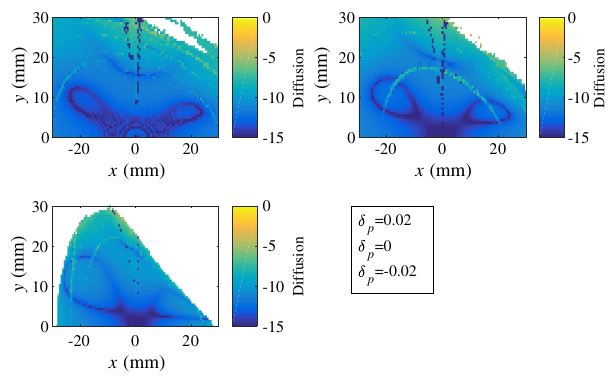
FIG. 8. Diffusion rate of particles distributed uniformly in the beam